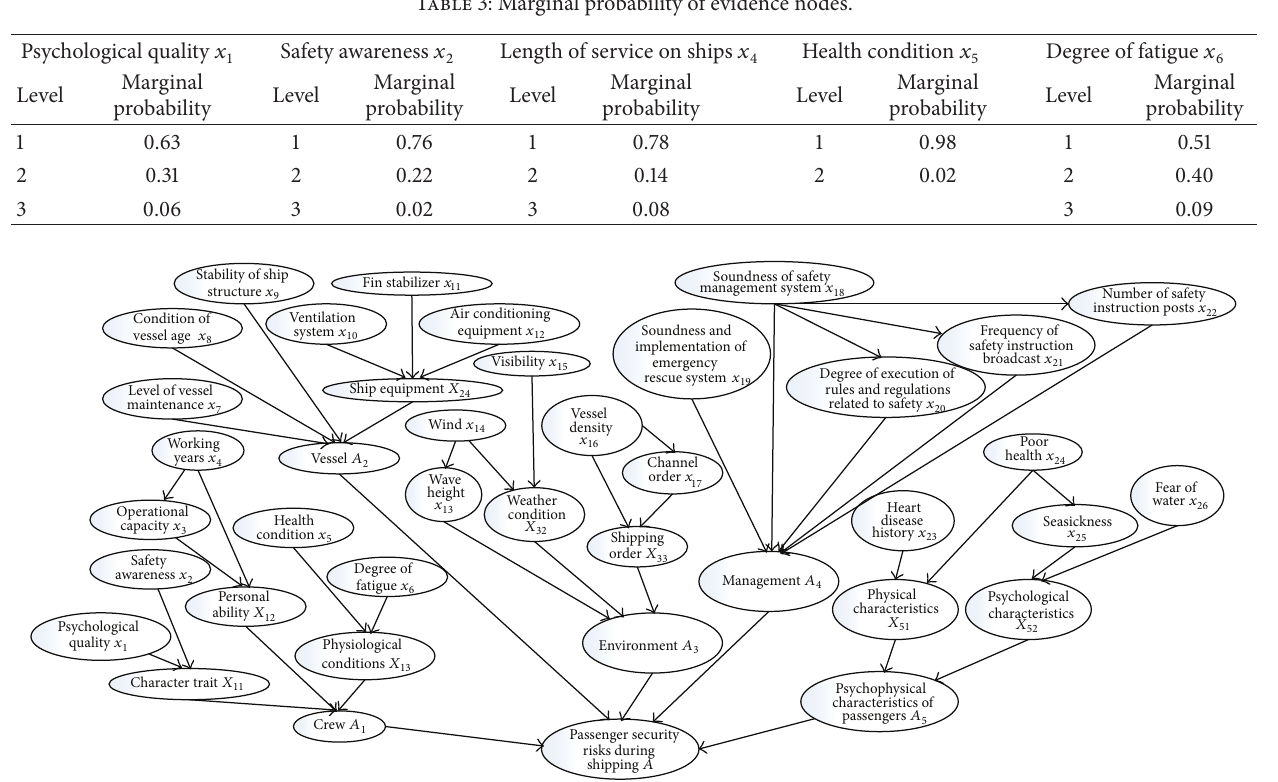
Figure 2: Bayesian network topology of passenger security monitoring during shipping.